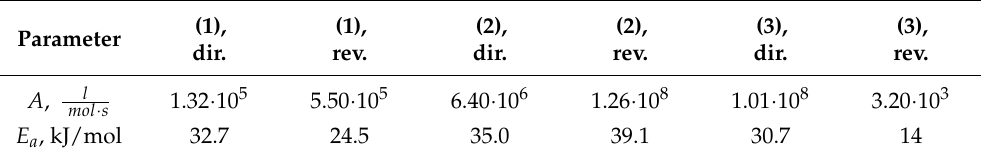
Table 4. The parameters of the temperature dependencies of the rate constants of direct and reverse reactions of TS and DCS